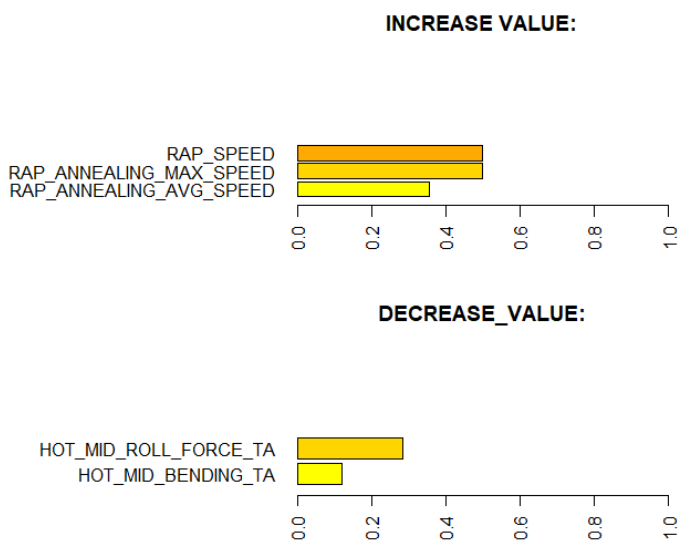
Figure 19. Recommended actions for an operator when a product has a bad predicted quality with Model _HYBRID.